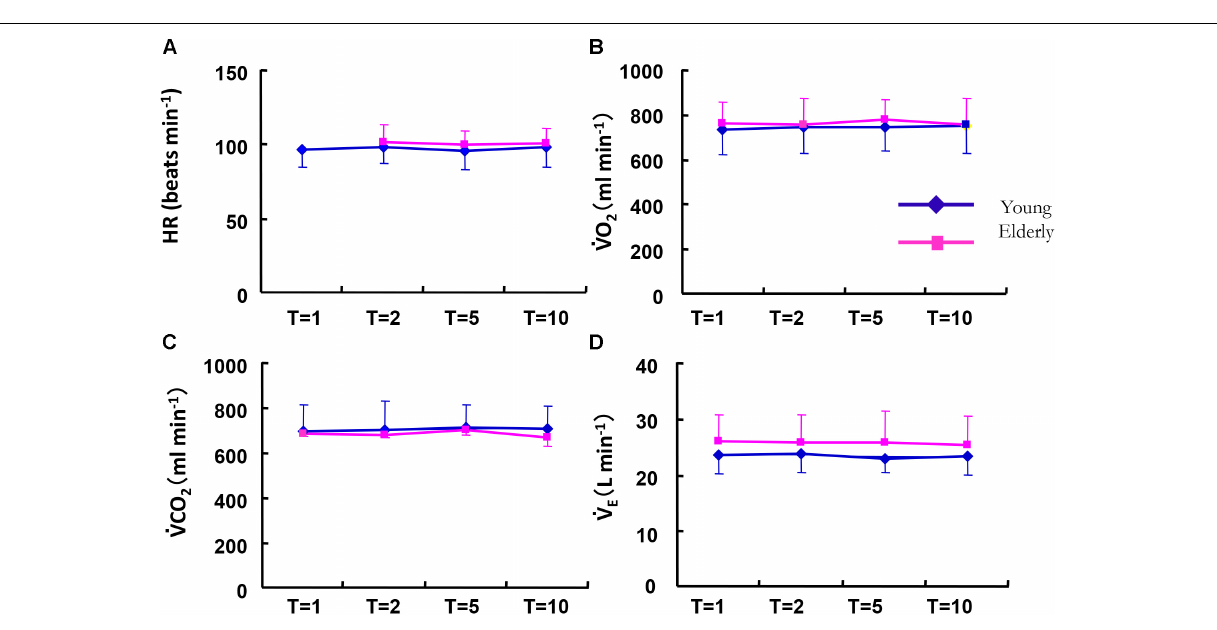
FIGURE 4 | Comparison of the averaged mean values ( Mx ) of HR (A) , ˙VO 2 (B) , ˙VCO 2 (C) , and ˙V E (D) between the elderly ( red line ) and younger individuals ( blue line ) as a function of the period of the sinusoidal changes in treadmill speed. There were no significant differences in all variables between the YG and ELD in any of the different periods. Note that the metabolic demand was similar between the YG and ELD during sinusoidal walking. Data are mean ±